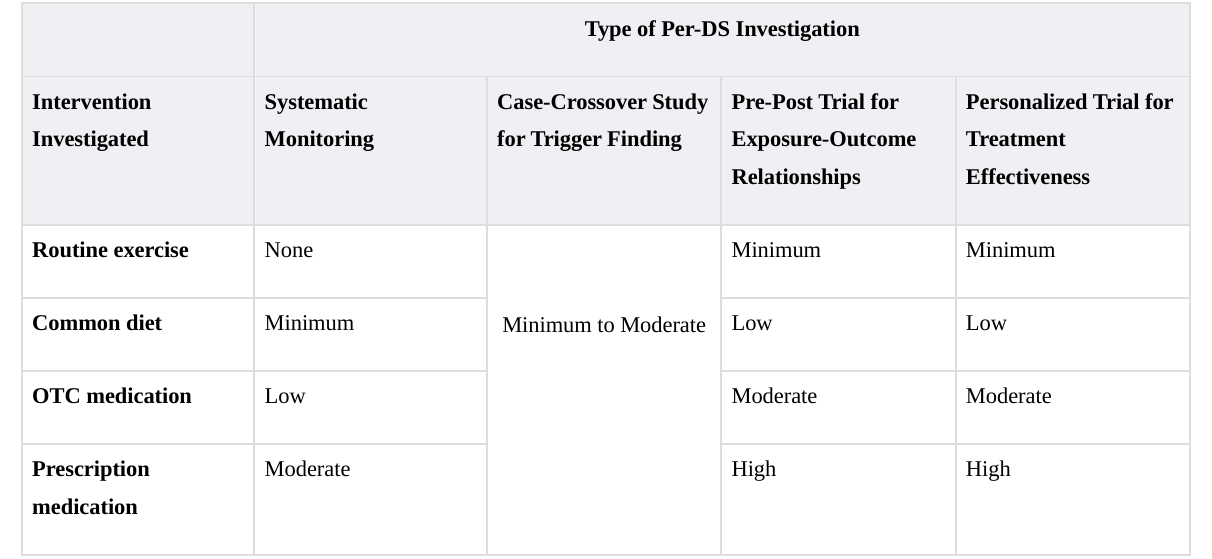
Table 5. Clinician involvement needed for Per-DS